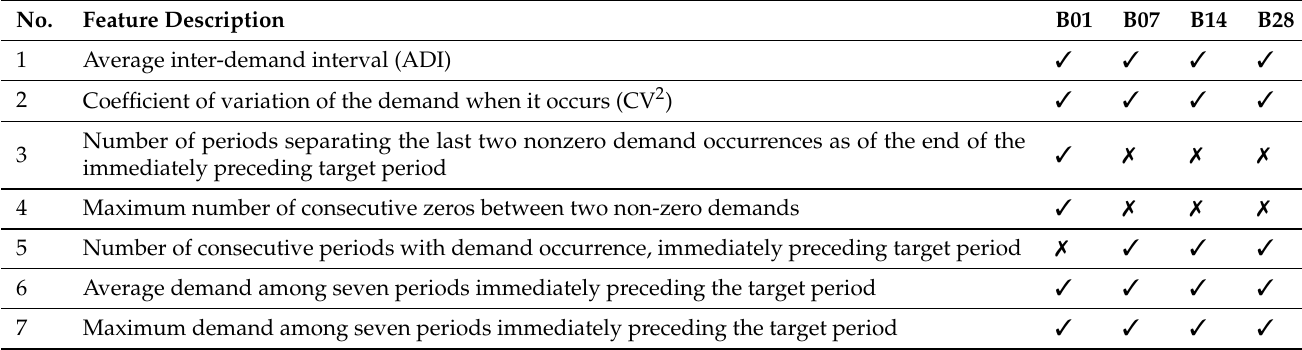
Table A1. Features used for the slow-moving series (M5 competition data set).